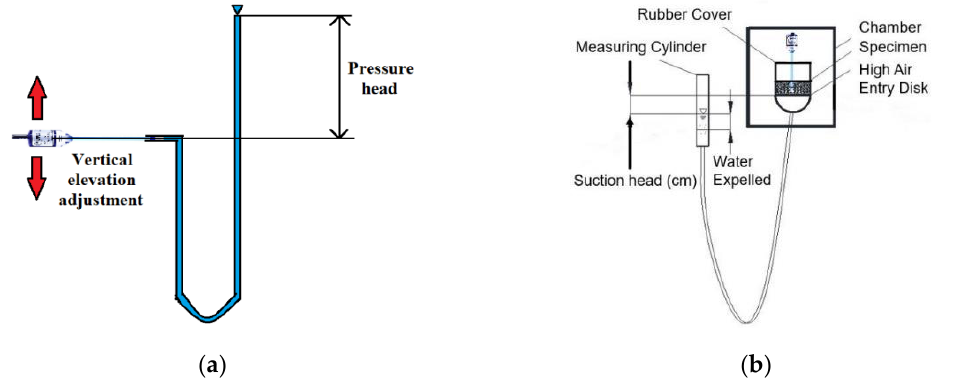
Figure 9. Two methods for calibrating T5 sensor voltage ratio output against actual soil water pore pressure: ( a ) the positive pressure – voltage ratio calibration using a U-shape manometer; ( b ) the negative pressure – voltage ratio calibration using the hanging column method with a suitable soil preset.